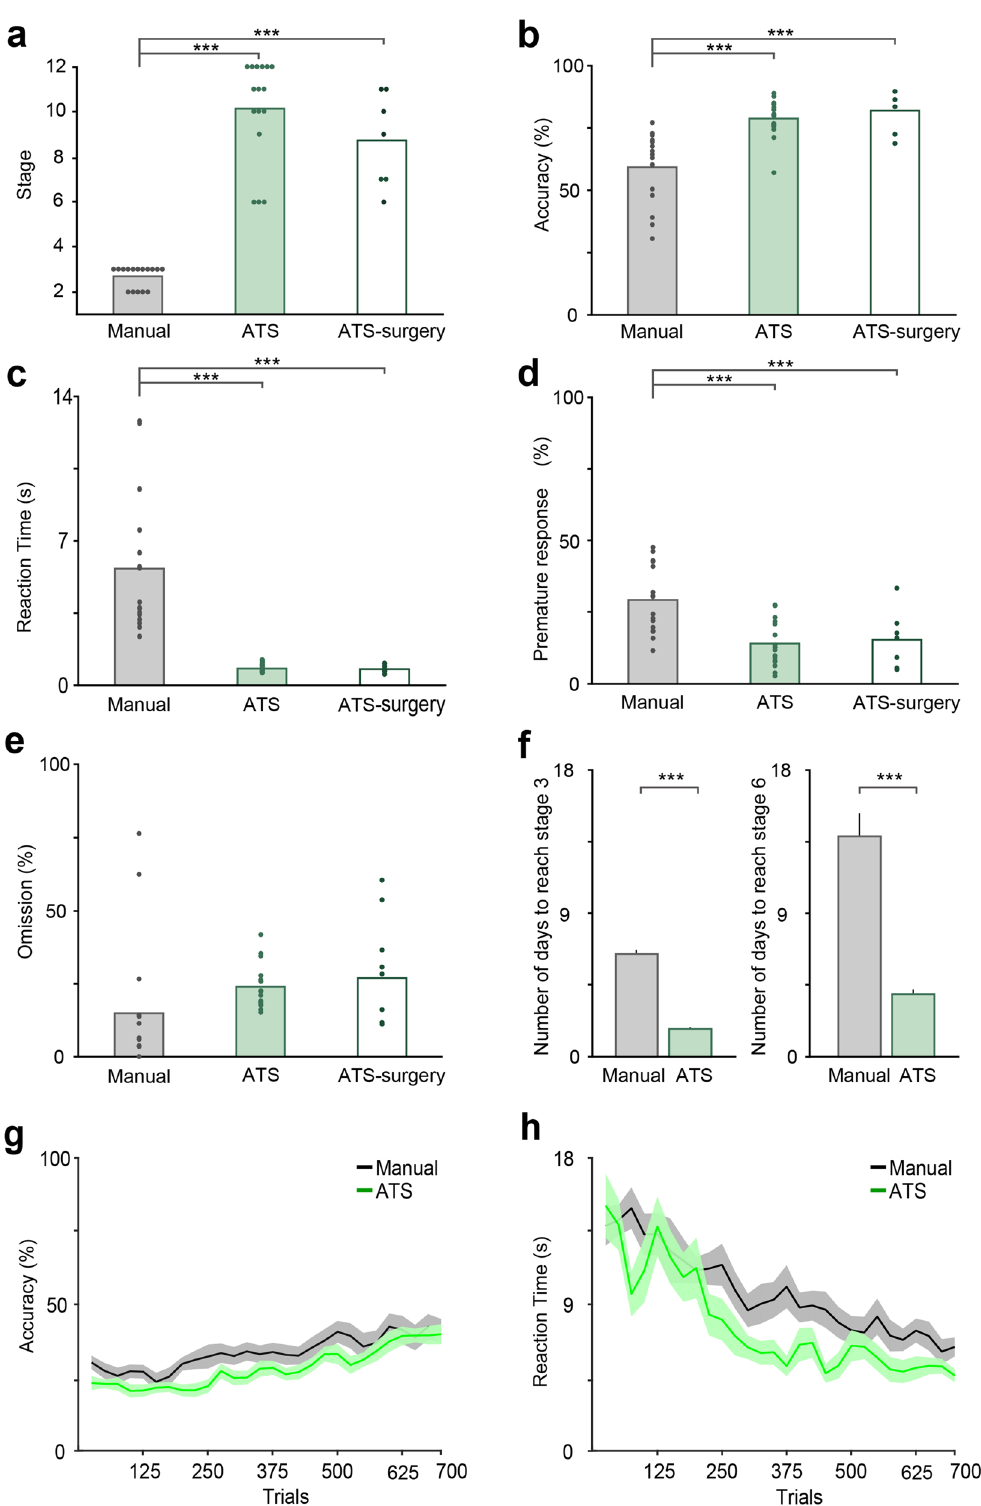
Figure 4. Mice reached better performance in the ATS in one week of training. ( a – e ) Behavior measures during the 7th day of training compared between groups of mice trained either manually, or in the ATS with (ATS-surgery), or without undergoing stereotaxic surgery. Bars, mean; dots, individual mice. Mice trained in the ATS reached higher stages ( a ), performed with higher accuracy ( b ), shorter reaction times ( c ), and performed fewer premature responses ( d ). There was no difference in omissions ( e ). Manual, N = 16; ATS, N = 16; ATS-surgery, N = 7. ( f ) Number of days needed to reach stage 3 and 6 in the manual setup and in the ATS. Stage 3, manual N = 13; ATS, N = 16; stage 6, manual N = 8; ATS, N = 16; two manually trained mice failed to reach stage 6 in 21 days of training (not included). ( g – h ) Accuracy ( g ) and reaction time ( h ) calculated for the first 700 trials of training (in 50 trial-windows with 50% overlap) for manually (grey) and ATS-trained (green) mice; lines and error shades represent mean ± SEM. Manual, N = 16; ATS, N = 16; ATS-surgery, N = 7. ***, p < 0.001; one-way ANOVA and repeated-measures ANOVA ( g – h